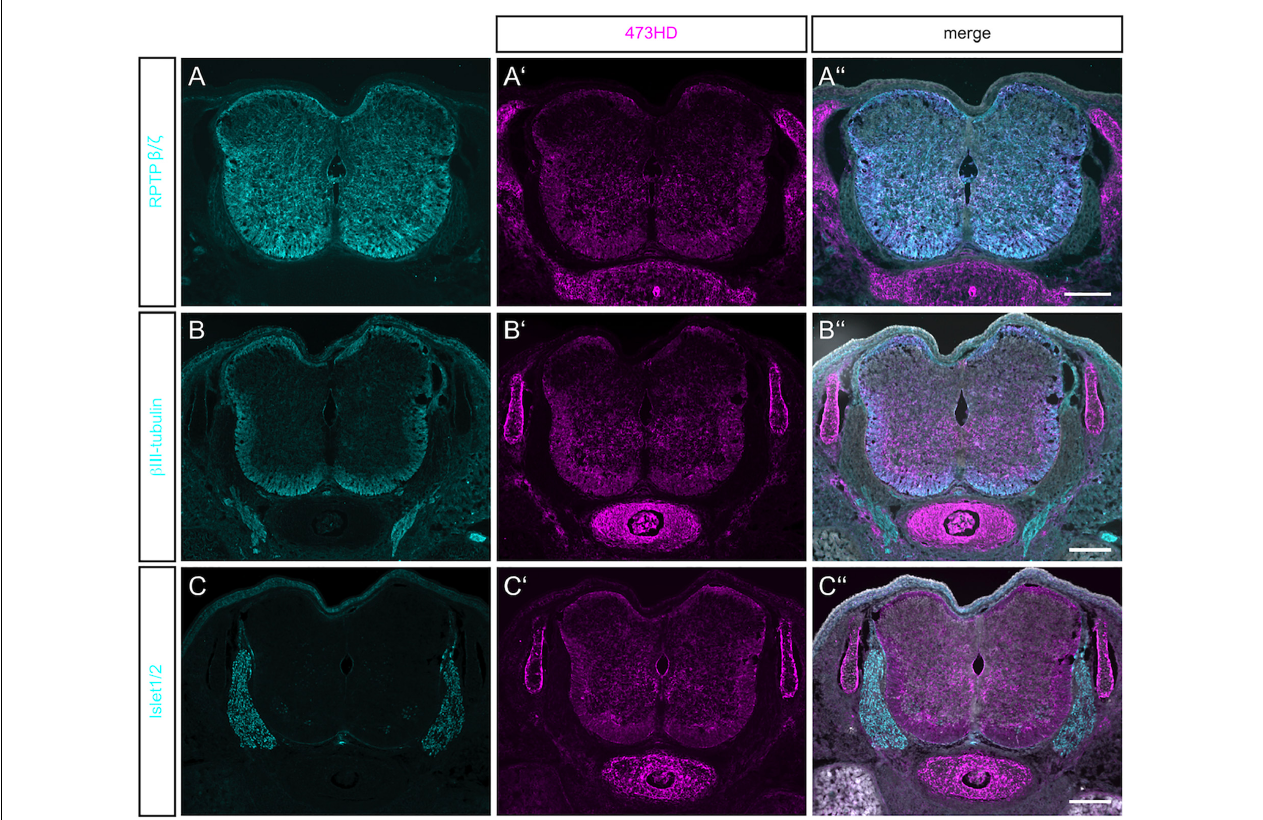
FIGURE 1 | Detection of RPTP β / ζ /DSD-1-PG in the embryonic spinal cord. (A) Immunohistochemistry with the polyclonal antibody anti-phosphacan revealed the expression of the CSPGs RPTP- β / ζ and DSD-1-PG/phosphacan in E15.5 mouse spinal cord. No labeling could be observed outside the CNS. (A (cid:48) ) The monoclonal antibody 473HD recognizes a specific carbohydrate motif on CSPGs that is present on RPTP- β / ζ /DSD-1-PG. Immuno-positive structures could also be found outside the CNS, especially in the underlying cartilage. (A (cid:48)(cid:48) ) The overlay of both labels and the nuclear DAPI staining (in white) showed a co-localization in the spinal cord, but solely 473HD-positive structures outside the CNS. (B) Young neurons in the developing spinal cord could be labeled with β III-tubulin which is present especially in the ventral marginal zone. There, the expression partially overlapped with 473HD staining (B (cid:48) ,B (cid:48)(cid:48) ) (C,C (cid:48) ,C (cid:48)(cid:48) ) . The immune-positive signals for 473HD surrounded scattered Isl-1/2-positive nuclei in the ventral spinal cord but showed no reactivity in the dorsal root ganglia (DRG) where Isl-1/2-positive motoneuron nuclei were arranged. Scale bars: 200 µ